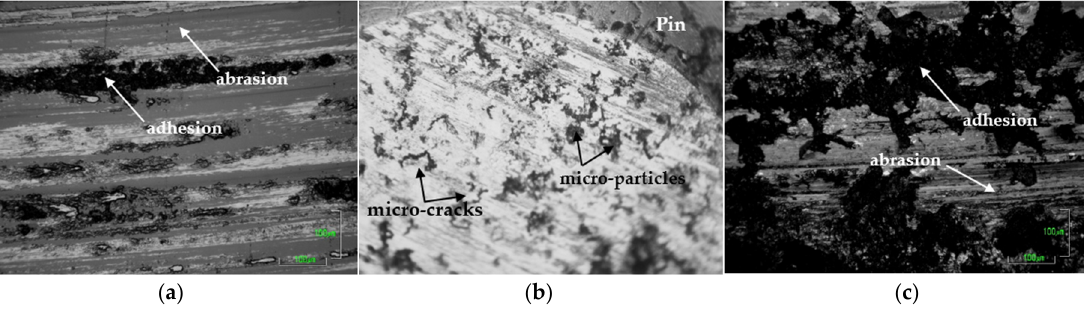
Figure 6. ( a ) Wear track of bare soda ‐ lime glass after sliding for 500 m against stainless steel (30 cm/s, 5 N, 500 m); ( b ) Counterface pin after sliding against bare soda ‐ lime glass (30 cm/s, 5 N, 500 m); ( c ) Wear track of bare soda ‐ lime glass after sliding for 500 m against stainless steel for intense